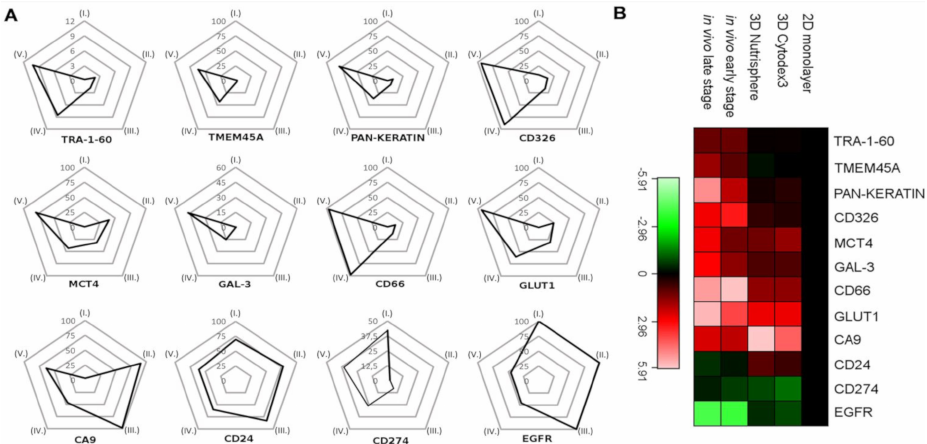
Figure 8. ( A ) Trajectories tend to localize to early and late stage tumors in the case of TRA-1-60, TMEM45A, pan-keratin, CD326, MCT4, GAL-3, CD66, and GLUT1. Percentage of HLA-A,B,C positive cells (A549) from a representative experiment were plotted on trajectories among five different conditions: (I) 2D monolayer, (II) 3D Cytodex3, (III) 3D Nutrisphere, (IV) early and (V) late stage in vivo adenocarcinoma. ( B ) Heatmap of mass cytometry data regarding protein density at single cell resolution among the five different conditions normalized to 2D monolayer (green: low, red: high